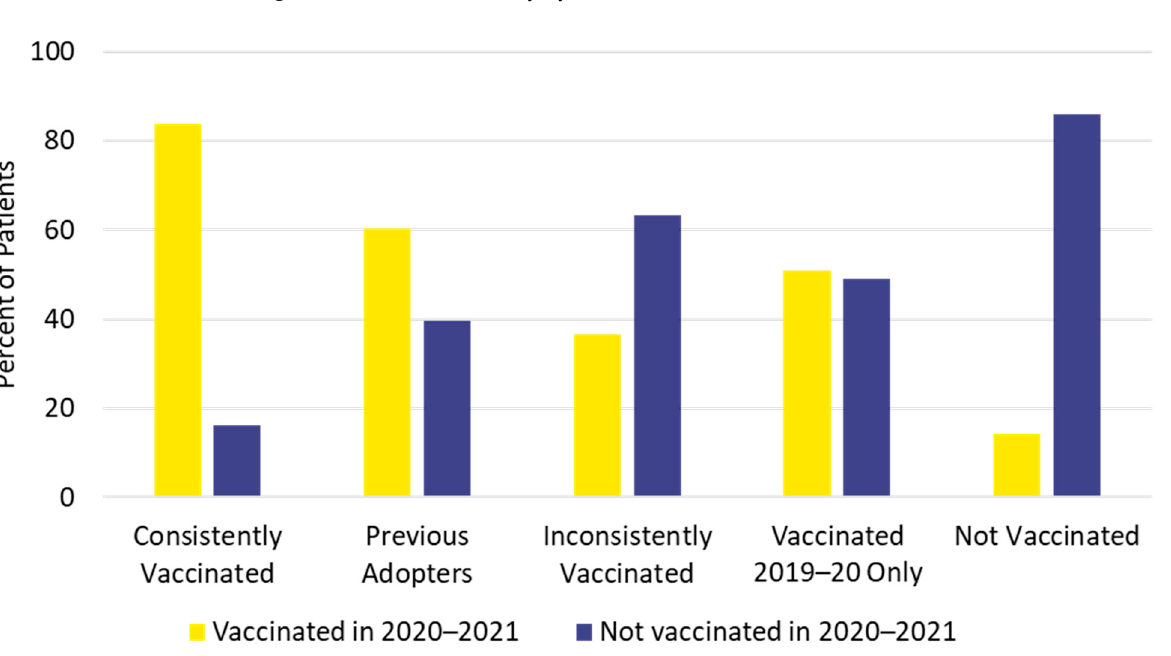
Figure 5. Vaccination history by race.